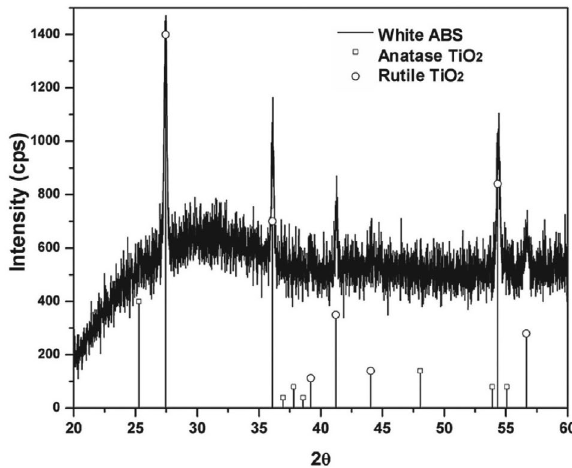
Figure 3. X-ray diffractogram of ABS dissolution with dye.